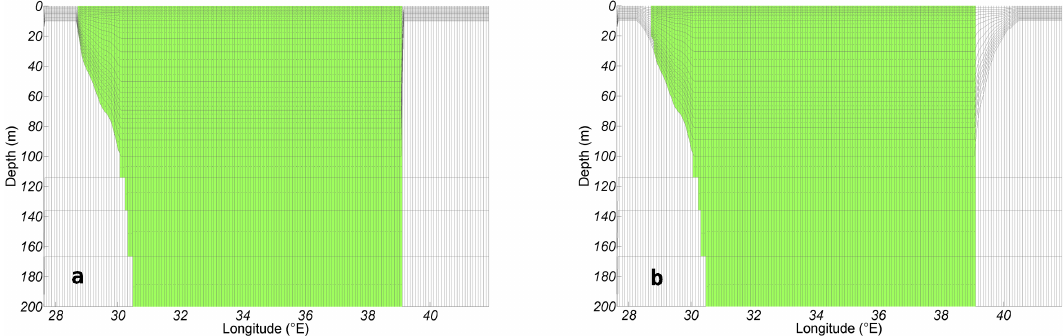
Fig. 3. Same as Fig. 2 for the new s–z hybrid grid (SZH) and the s–z hybrid enveloped grid